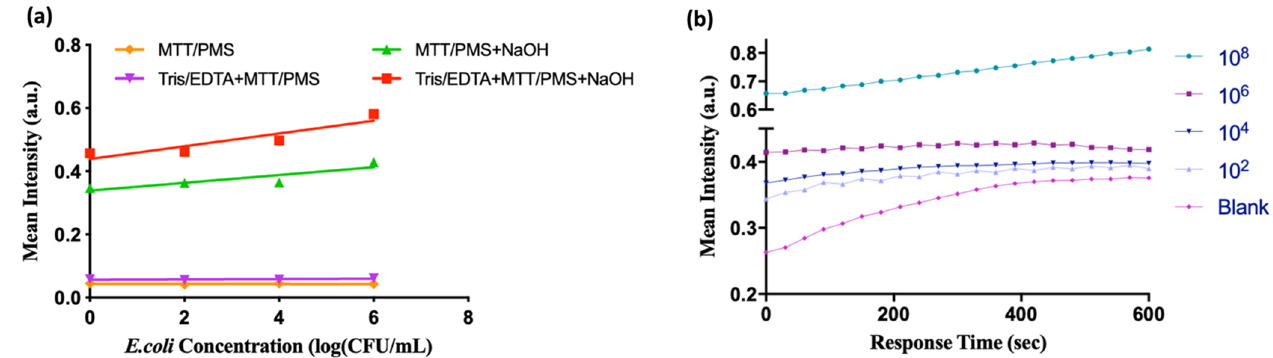
Figure 3. Establishment of the 3-(4,5-dimethylthiazol-2-yl)-2,5-diphenyltetrazolium bromide-phenazine methosulfate (MTT-PMS) bacterial detection assay protocol: ( a ) Functional validation of each reagent: The colorimetric results of MTT-PMS and Tris/EDTA + MTT-PMS assays demonstrated no differences in bacterial concentration at 5 min (purple and orange lines). In the group treated with MTT-PMS + NaOH, a semi-quantitative colorimetric signal was observed at 5 min (green line). With the addition of Tris-EDTA + MTT-PMS + NaOH, the quantitative colorimetric response became visible (red line). The slope of the green line is 1.6-fold higher than that of the blue line (0.02 vs. 0.012); ( b ) Dynamic colorimetric results of the MTT-PMS assay at 595 nm. Signals were recorded every 20 s for 10